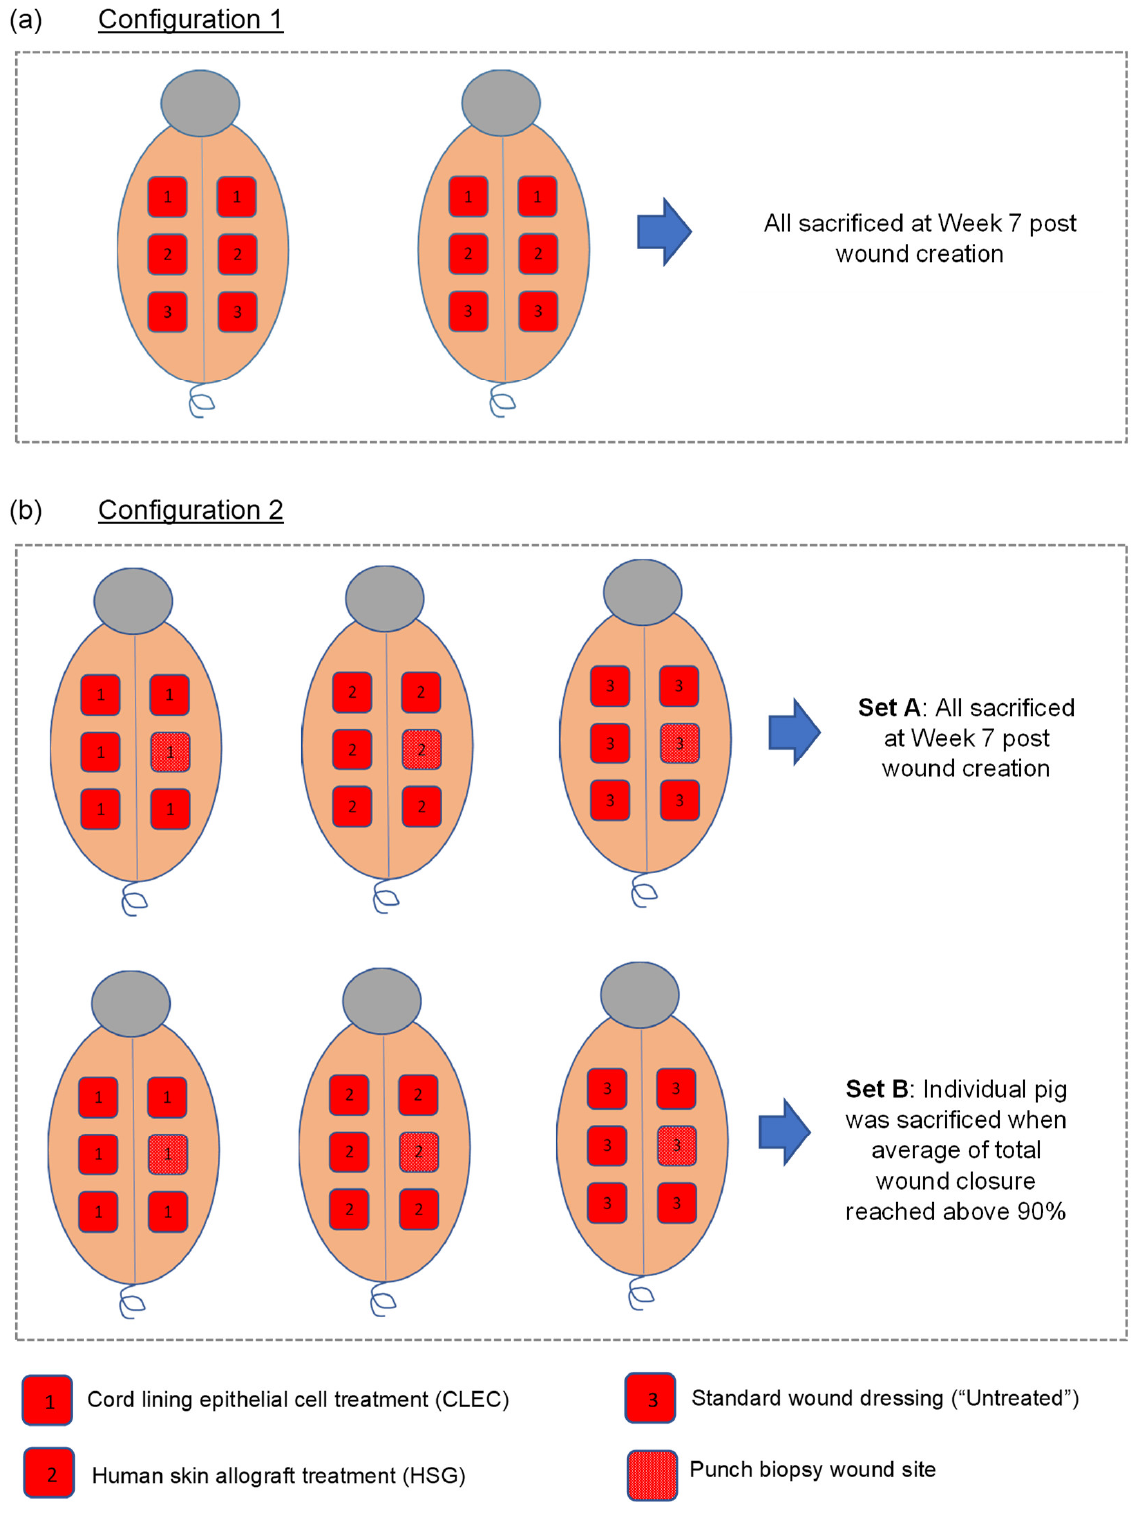
Figure 4. Wound treatment configurations for pigs created with full thickness excisional